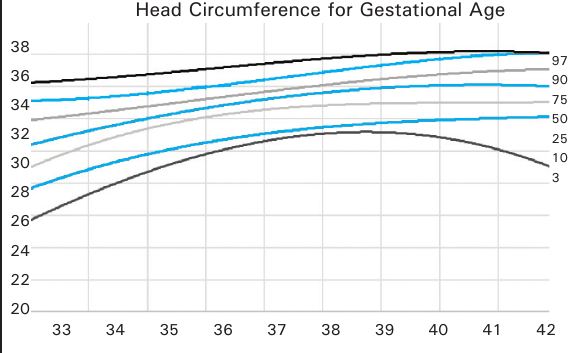
Figure 4. Smoothed curve for head circumference.